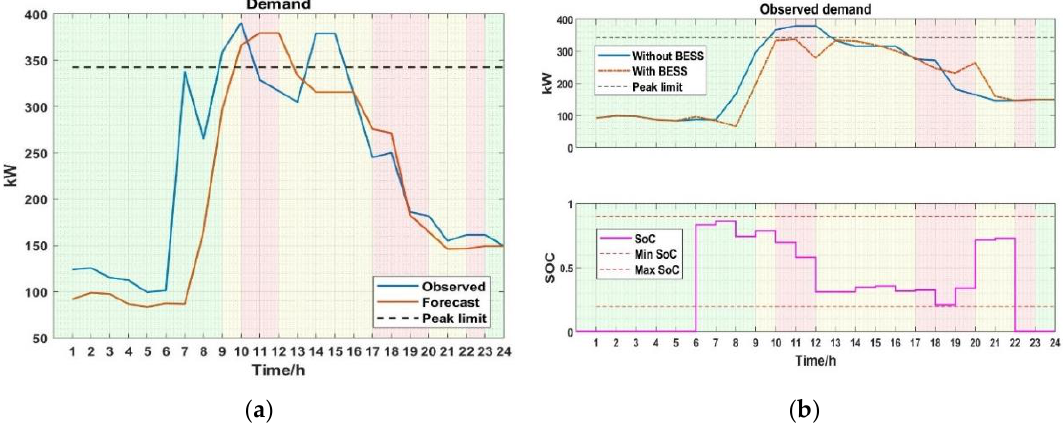
Figure 7. ( a ) Day ahead out of sample demand forecast vs. observed demand; ( b ) PEVs’ schedule deterministic optimization (DO) using forecasted demand.